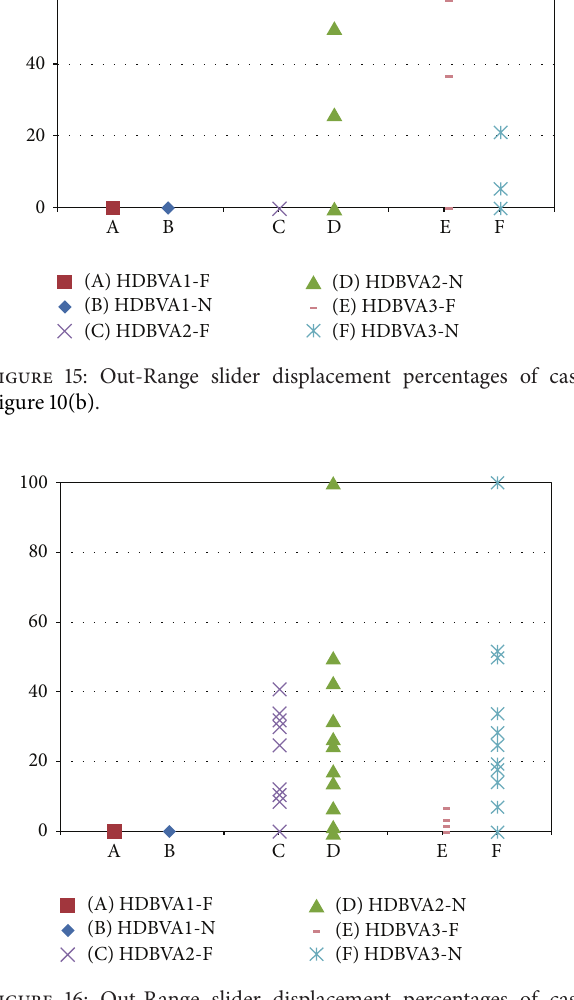
Figure 16: Out-Range slider displacement percentages of case Figure